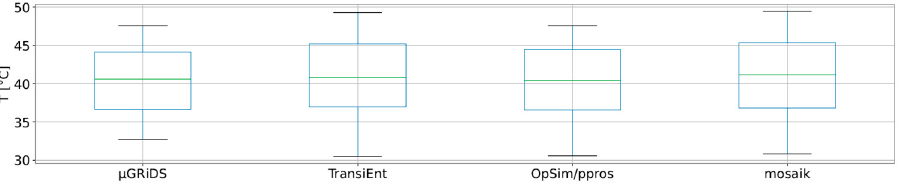
Figure 11. Boxplot of the mean temperature in the hot water storage.